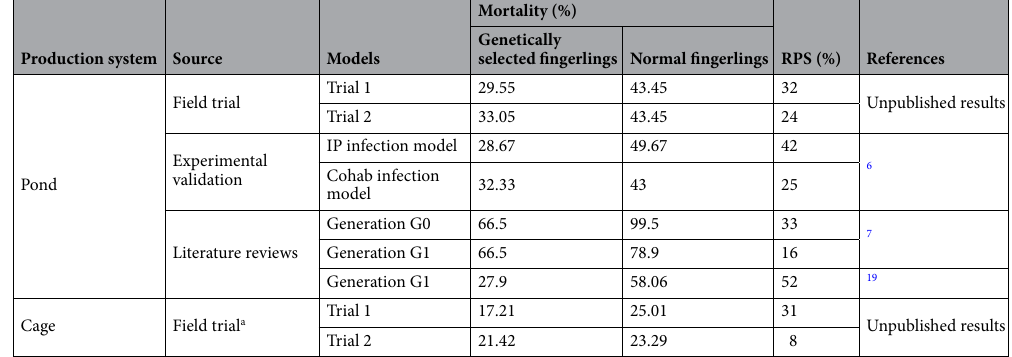
Production system